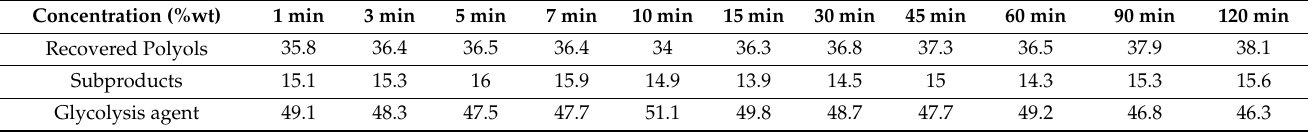
Table 3. Concentration in percentage of each of the components of the product of the reaction 56 at different times: recovered polyol, by-products, glycolysis